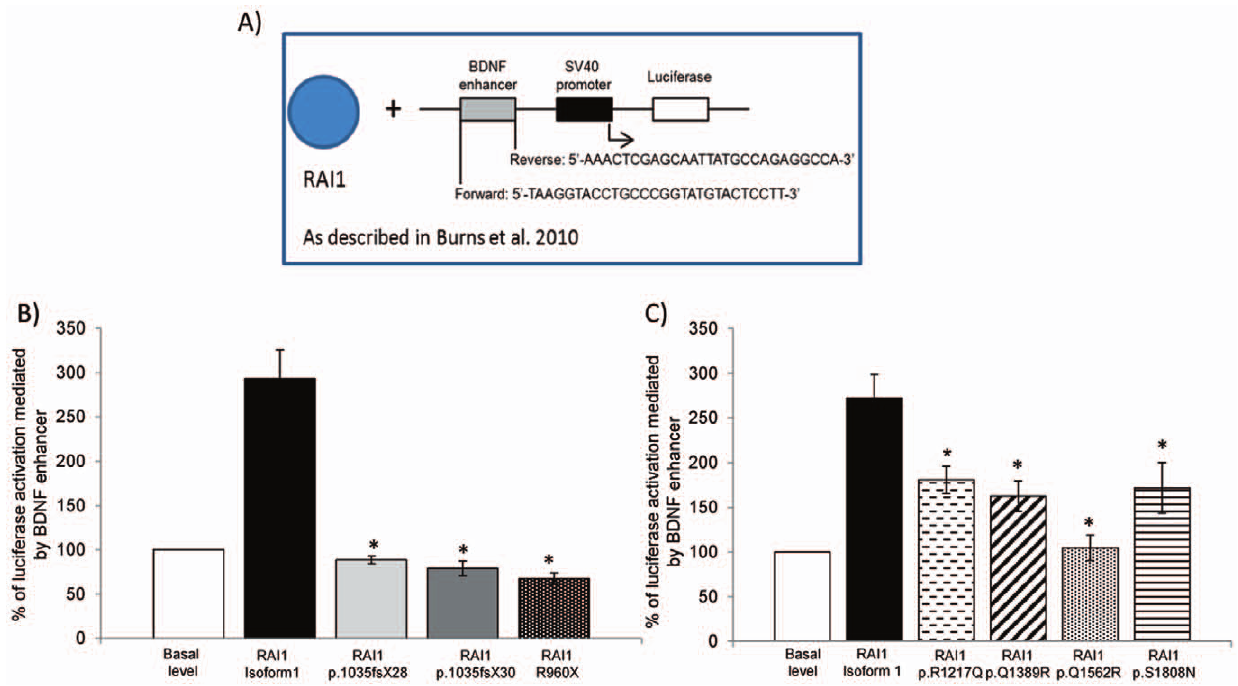
Figure 4. BDNF enhancer transactivation activity for two groups of RAI1 mutations. A) Schematic representation of the plasmid construct used to measure the transactivation activity of RAI1 wild type or the mutants forms driven by the BDNF enhancer in HEK293T cells. The intronic sequence for BDNF gene enhancer region was amplified by PCR and added upstream of the SV40 promoter. B) HEK293T cells were co-transfected with a BDNF fused luciferase reporter plasmid, a b -galactosidase reporter plasmid, and either RAI1 isoform 1, p.1035fsX28, p.1035fsX30 or RAI1 R960X. Forty eight hours post-transfection the reporter proteins were measured from the cell lysates. Activation of the reporter for empty vector along with BDNF fused luciferase reporter plasmid and a b -galactosidase reporter plasmid (basal endogenous BDNF level) was used for normalization. (p # 0.002). RAI1 isoform 1 n=9, RAI1 p.1035fsX28 n=6, RAI1 p.1035fsX30 n=9, RAI1 R960X n=6. Values represent mean 6 SEM. (*=p , 0.05). C) The same experiment was performed for group 2 of point mutations mapping at the C-terminal half of RAI1. All the proteins analyzed exhibit impaired activation of the endogenous target BDNF . RAI1 isoform 1 n=3, RAI1 p.R1217Q n=4, RAI1 p.Q1389R n=4, RAI1 p.Q1562R n=6 and RAI1 p.S1808N n=9. Values represent mean 6 SEM. (*=p ,